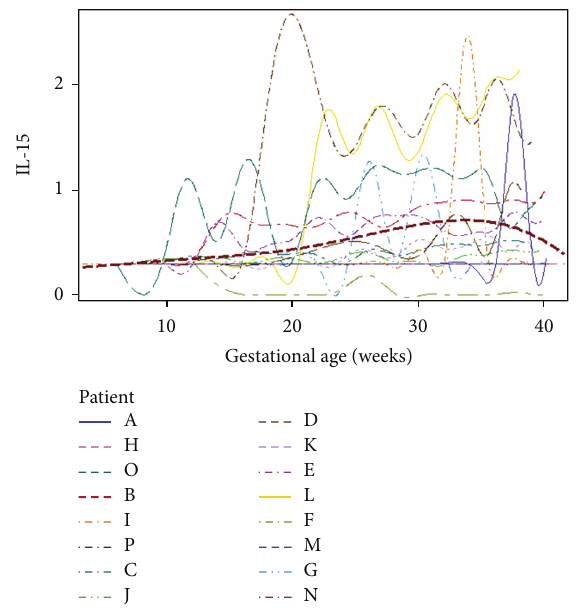
Figure 4: Growth curve of IL-15, with data from all patients super- imposed, and with the average of all of the plots represented by the dashed red line.